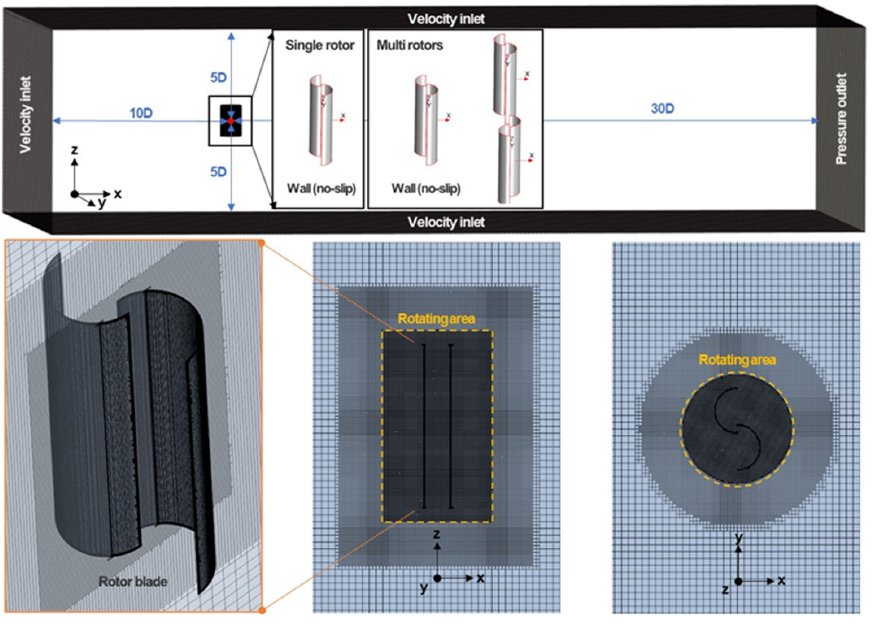
Figure 1. Boundary conditions and model for CFD analysis.